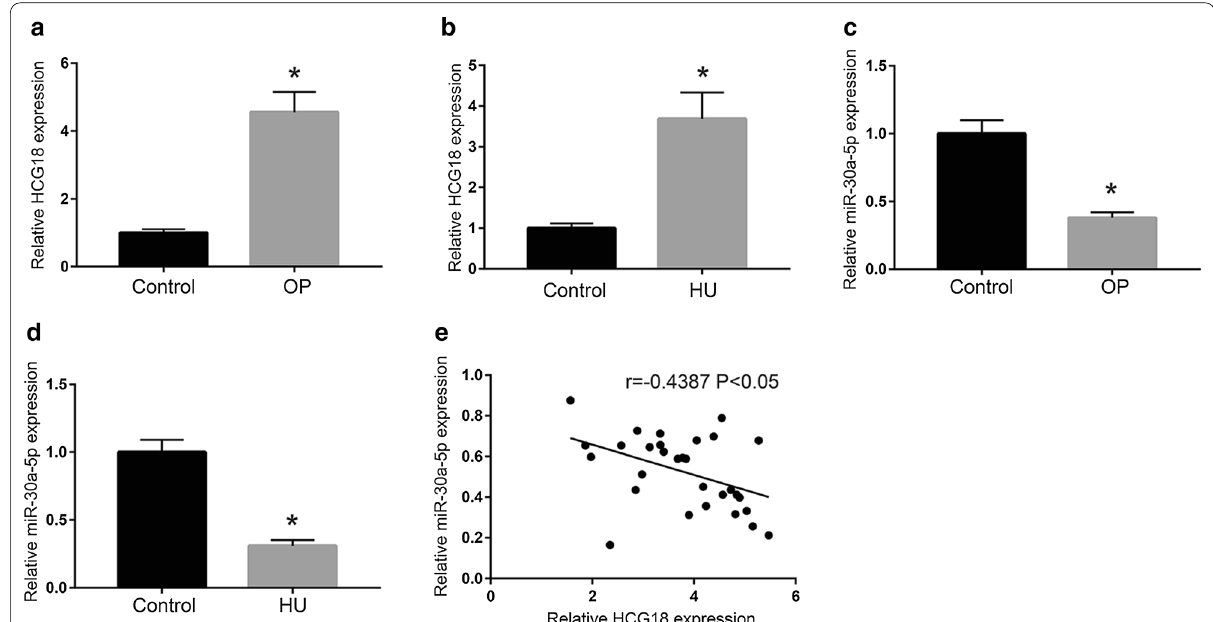
Fig. 1 Expression of HCG and miR-30a-5p in BMSCs of OP and HU. a , b Expression of HCG18 in OP (n Expression of miR-30a-5p in HU (n expression of miR-30a-5p (n